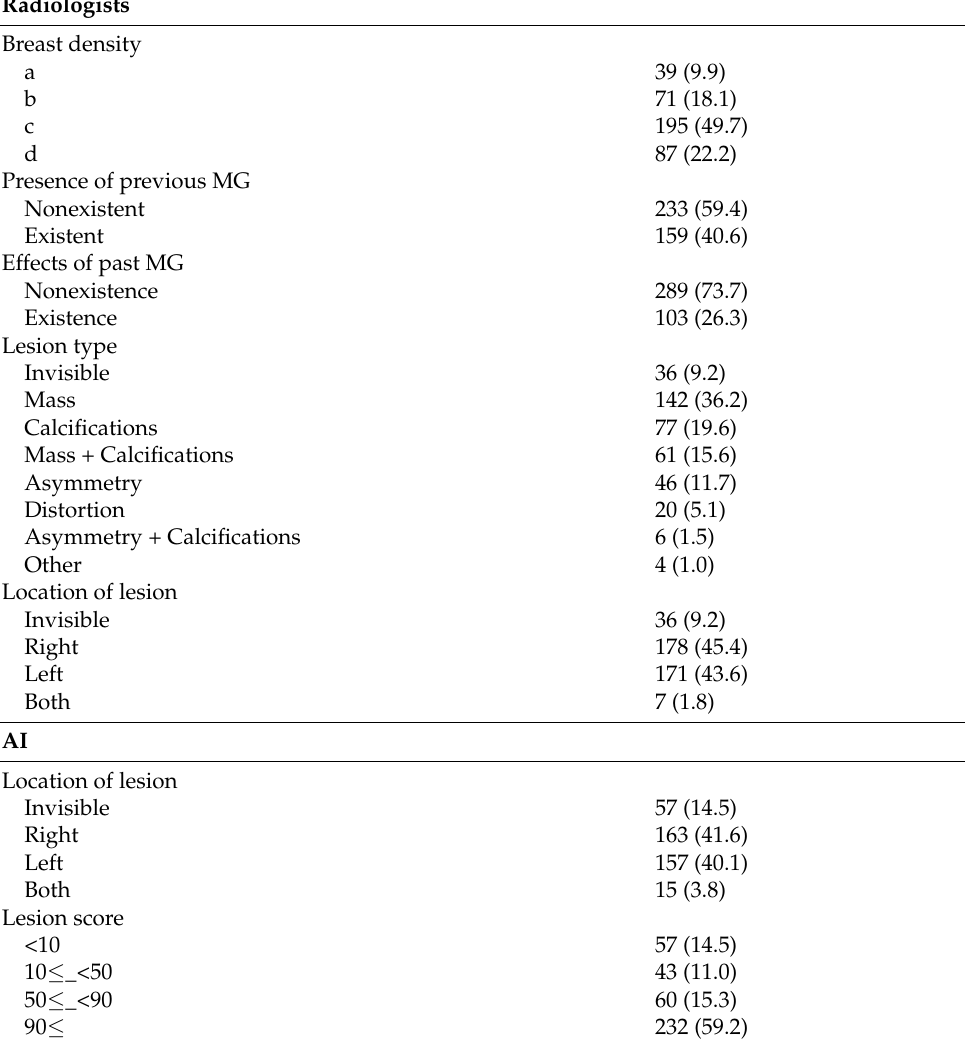
Table 2. Analysis of mammography by radiologists and AI.